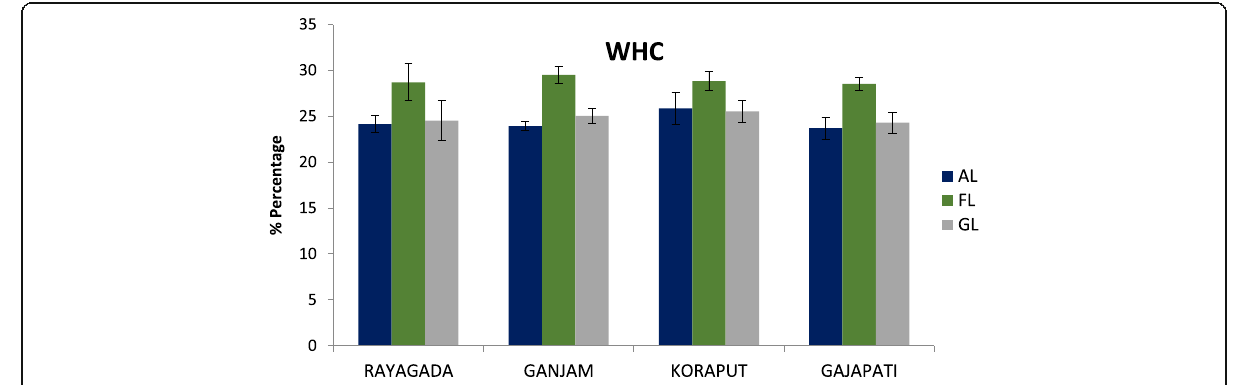
Fig. 4 Water holding capacity of soil with means under different habitat conditions across four districts